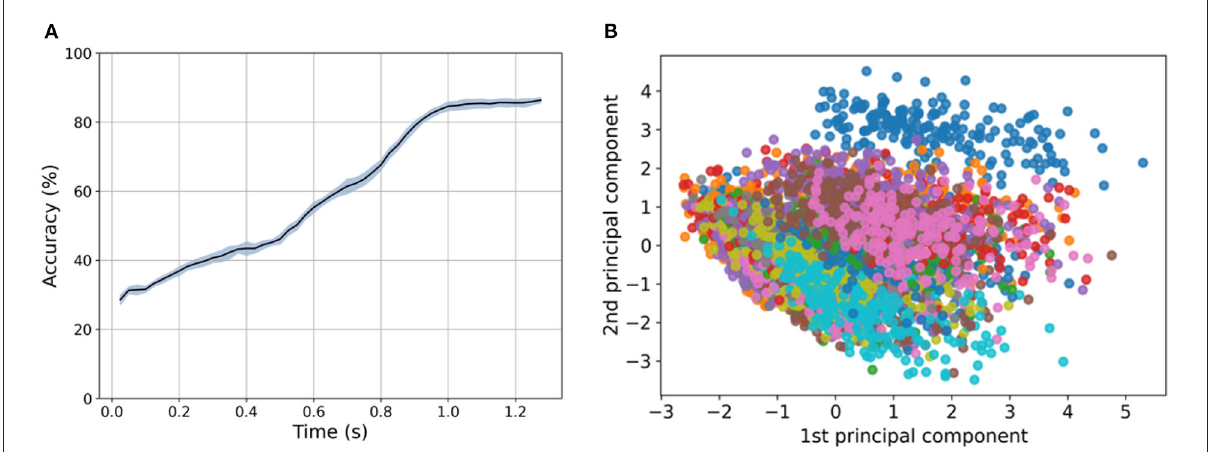
FIGURE5 (A) Dependency of SVM performance in regard to the first 12 principle components extracted using PCA provided with an increasing number of frames. An increase in the number of frames results in an increase in the performance close to saturation in 1s at (86.7 ± 0.77)%. (B) Dimensionality reduction (PCA) with 2 components applied to the spatio-temporal sequences of the frame-based dataset. Each of the colors in the visualization represents a category (letter) in the dataset.